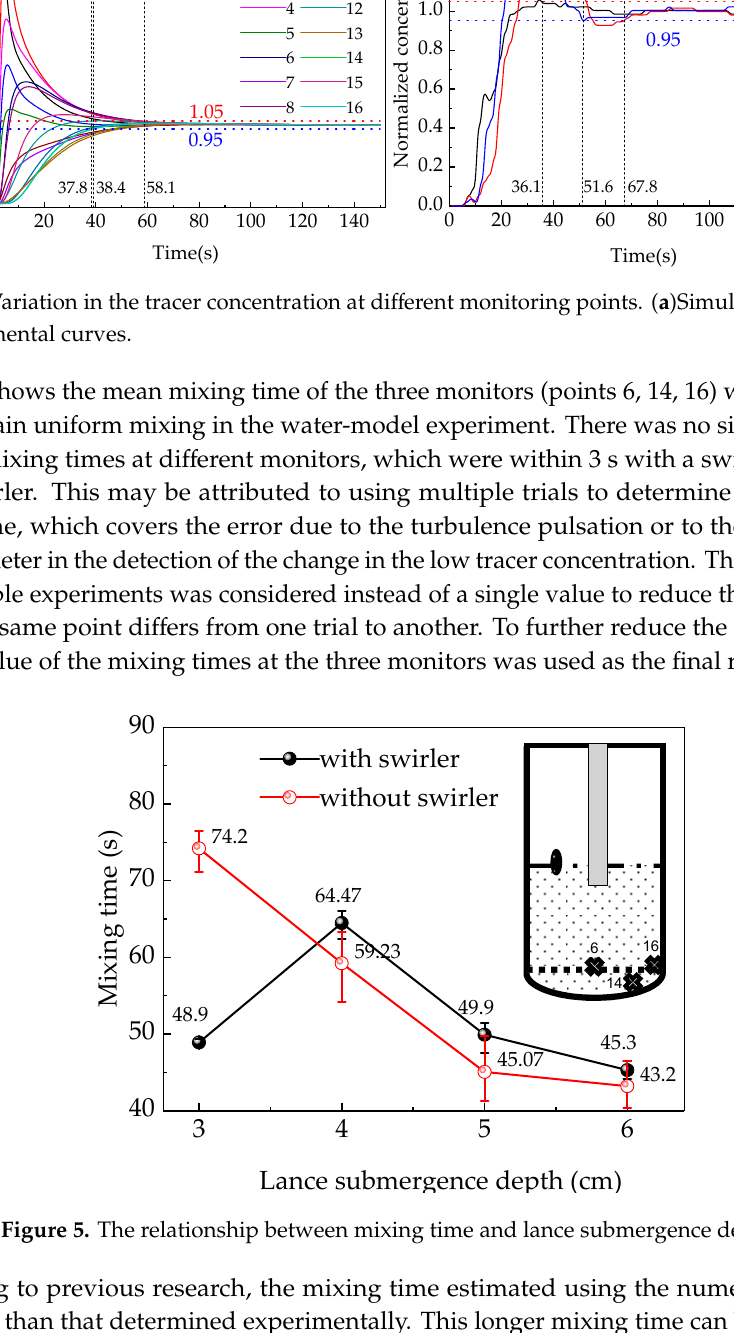
( c ) Figure 3. Comparison of gas-liquid distribution between experimental the simulated results. ( a ) Simulated result, ( b ) experimental result and ( c ) measuring of gas penetrated depth. 3.2. Effect of Lance Submergence Depth and Swirler on Mixing Time In order to verify the accuracy of the numerical simulation, the mixing time was measured when a lance with and without a swirler was used at lance submergence depths from 3 to 5 cm in the water- model platform. Figure 4 shows the curves of the tracer concentration over time for the 16 monitors illustrated in Figure 2 in the simulations and the selected three corresponding points in the experiments. The mixing time could be identified when the fluctuation of the tracer concentration was less than ±5% and the mean value of the mixing times were calculated with at least two-way simulation repetition experiments for each condition of gas flow rate, lance diameter and lance depth. Figure 4 indicates that the mixing times at different monitors under the same conditions were